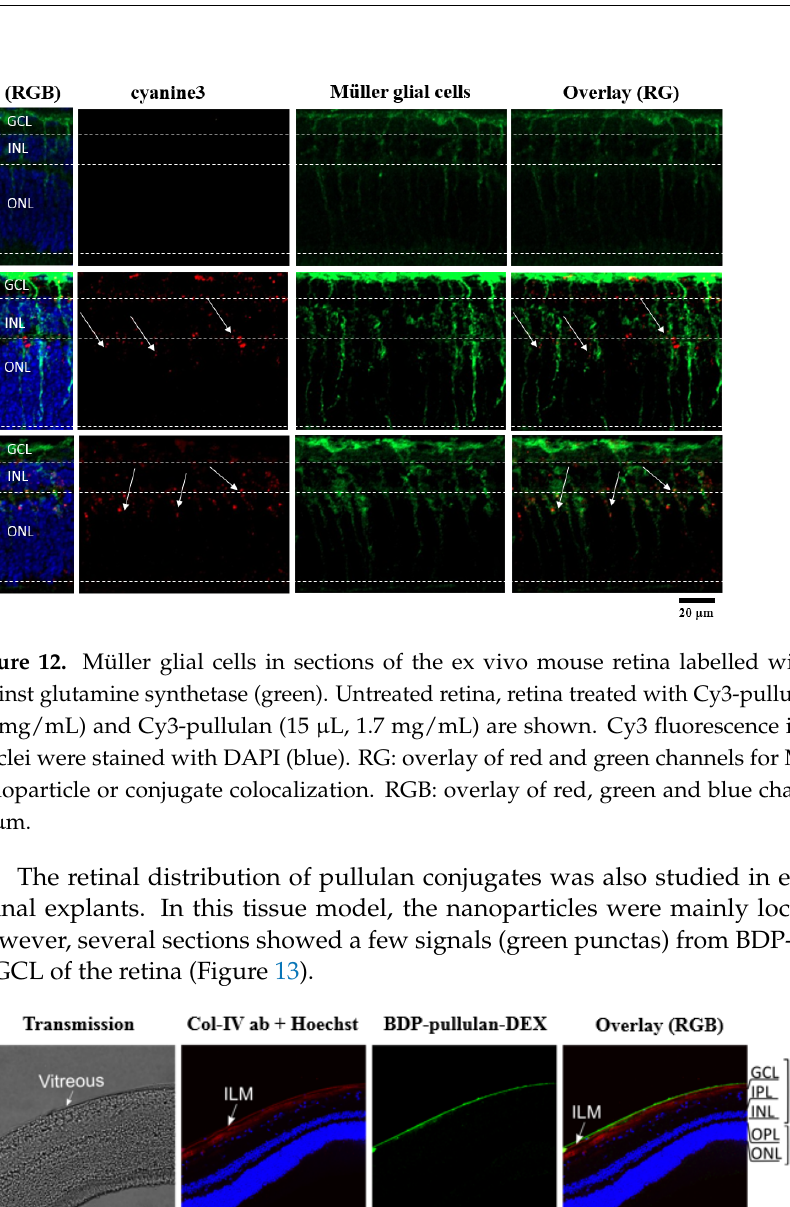
Figure 13. Retinal distribution of BDP-pullulan-DEX (100 μ L, 5 mg/mL) in the vitreo-retinal ex vivo bovine explant 24 h after intravitreal injection. Representative confocal microscopy images of cryo- sections display the penetration of BDP-pullulan-DEX in the retinal layers (green). The inner limit- ing membrane (ILM) was labelled with rabbit anti-collagen type IV antibody (Col-IV ab, red). The vitreous can be seen as transparent layer in transmission imaging which is well aligned along the ILM while it appears in bright green color due to the high load of BDP-pullulan-DEX in merged channel mode. Nuclei are stained with Hoechst (blue). The white bar on the right bottom corner of each picture indicates the bar size: 50 μ m. Abbreviations indicated in image: ganglion cell layer (GCL), inner plexiform layer (IPL), inner nuclear layer (INL), outer plexiform layer (OPL), outer nuclear layer (ONL), overlay of red/green/blue channels (RGB).